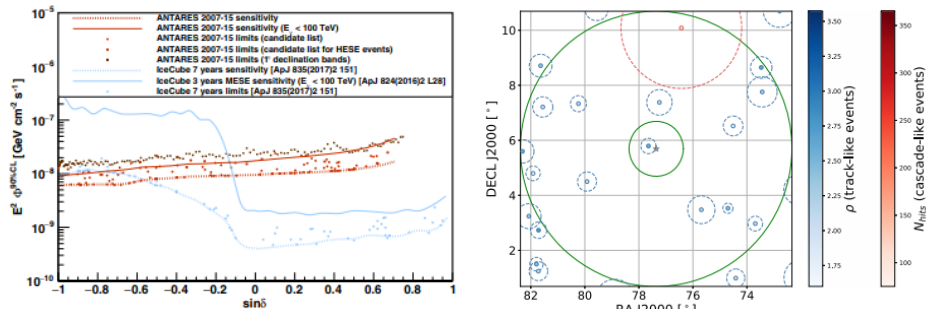
Figure 3 . Left: Limits in the cosmic neutrino flux as a function of the declination of the source. Sensitivities are also shown assuming a E -2 spectrum with no cut off (solid line) and a cut off in the neutrino energy at 100 TeV. Recents reults from IceCube are also shown. Right: Events around the most significant cluster in the all-sky search.